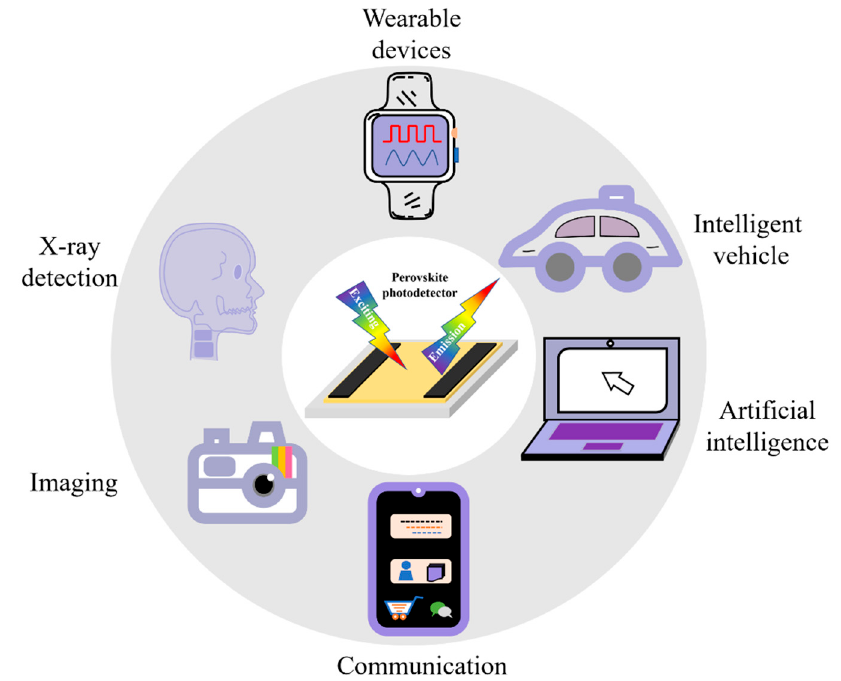
Figure 10. Perovskite photodetectors applications. (3) Compared with polycrystalline thin films, SCs have better stability and carrier transmission capacity, and fewer grain boundaries and defects. However, the reported perovskite SC photodetectors featured no significant performance improvement when compared with polycrystalline products. Therefore, strategies including improving the preparation process of perovskite SCs and growing flexible, large-area ultra-thin perovskite SC films are desirable for SCs devices